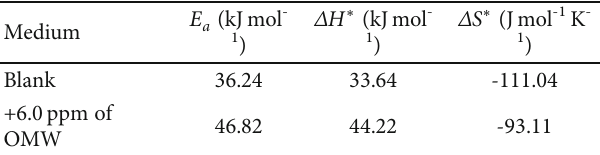
Figure 7: Arrhenius transition state plots of ln ð I of 1000/ T for the systems under study. Table 7: Determined activation energies for AA3003 corrosion in 1 M HCl medium without and with OMW inhibitor at 6.0 ppm.